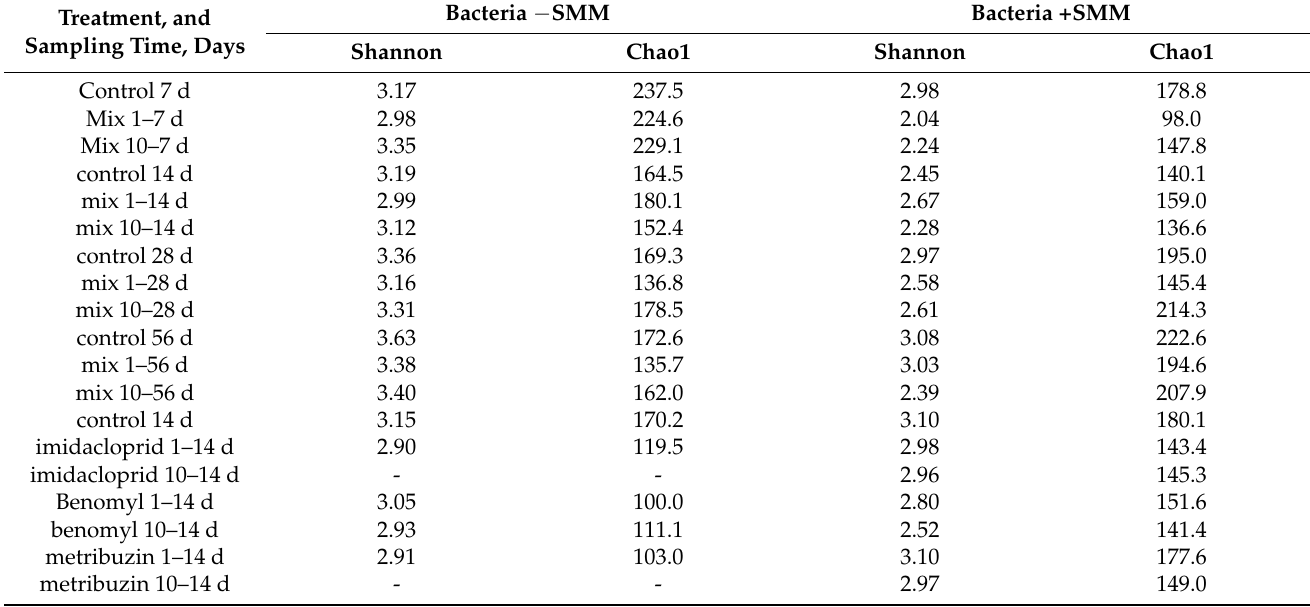
Table 5. Indices of alpha diversity of the bacterial community at the genus level in all variants of the